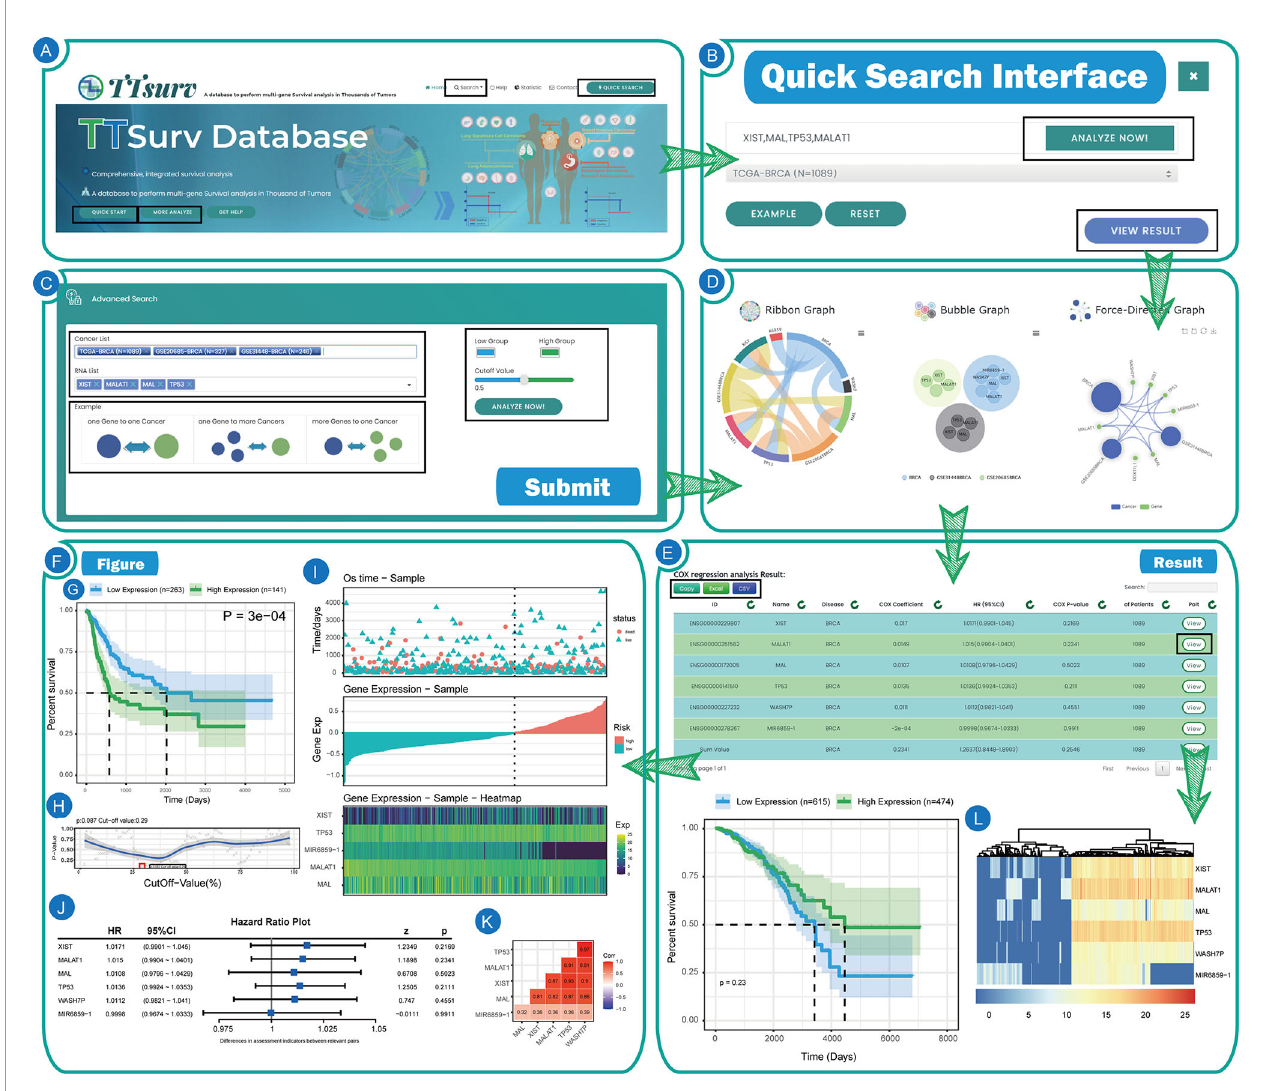
FIGURE 3 | The user interfaces and results of TTSurv. (A) Home page of TTSurv. (B) Quick search interface of TTSurv. (C) Query interface of TTSurv. (D) Pre- Result interface of TTSurv. (E) The result table and fi gures of TTSurv. (F) The diagram display of TTSurv. (G) The KM survival curve map. (H) The P-value curve obtained after each grouping. (I) The Survival time & gene expression integration map. (J) The forest plot. (K) The gene correlation plot. (L) The heat map obtained by unsupervised